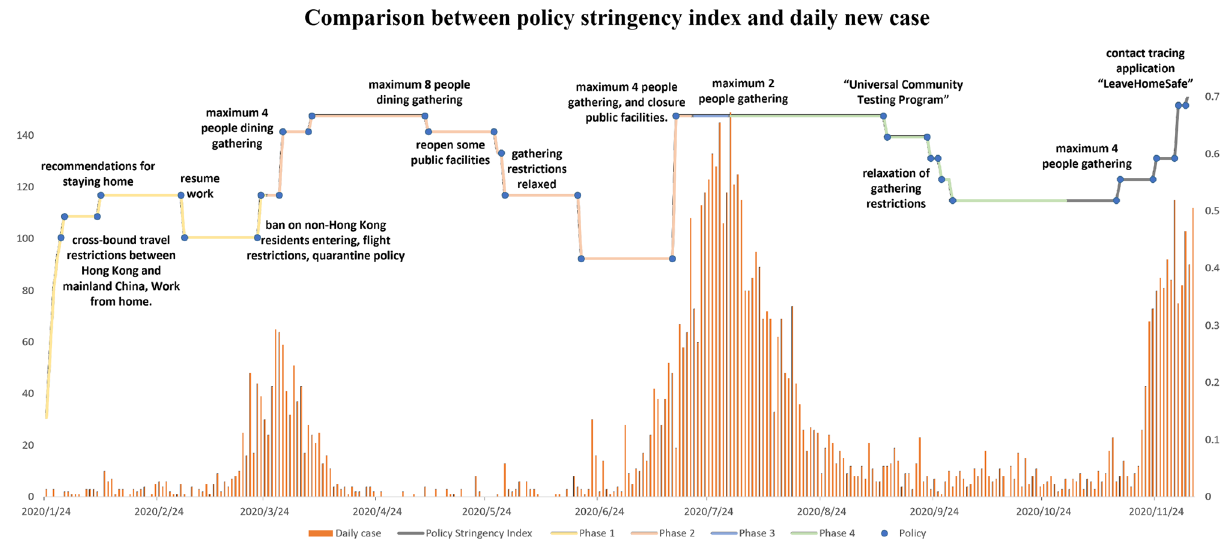
Figure 4. Comparison between policy stringency index scores 16 and daily new cases 17 from 24th January to 4th December 2020. Yellow, orange, blue and green lines represent the periods from Jan. 24 to Mar. 24, from May 25 to July 19, from July 20 to 29, and from July 30 to Oct. 30 respectively. Blue points show each inflection point of the grey line “policy stringency